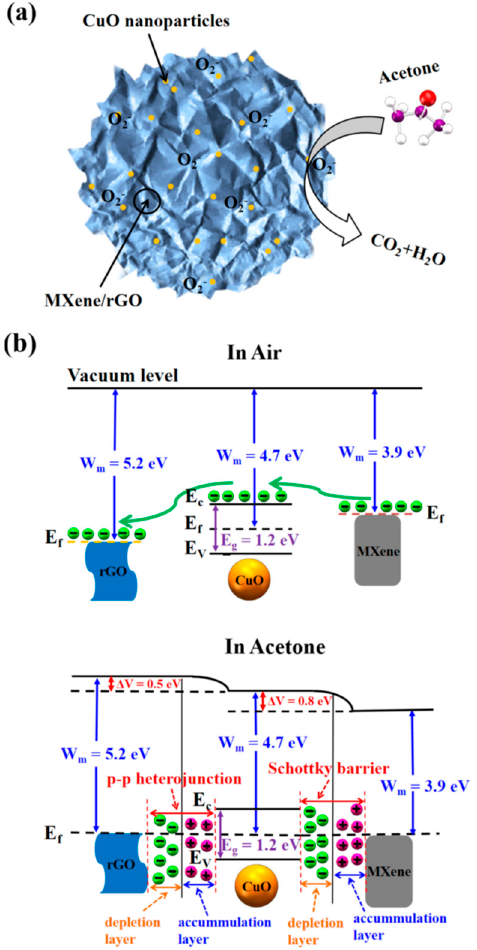
Figure 37. ( a ) Gas-sensing mechanism diagram of the 3D MXene/rGO/CuO aerogel to acetone gas. ( b ) Band structure diagram of the 3D MXene/rGO/CuO aerogel under different conditions. Reprinted with permission from [171]. Copyright 2021: Elsevier B.V.